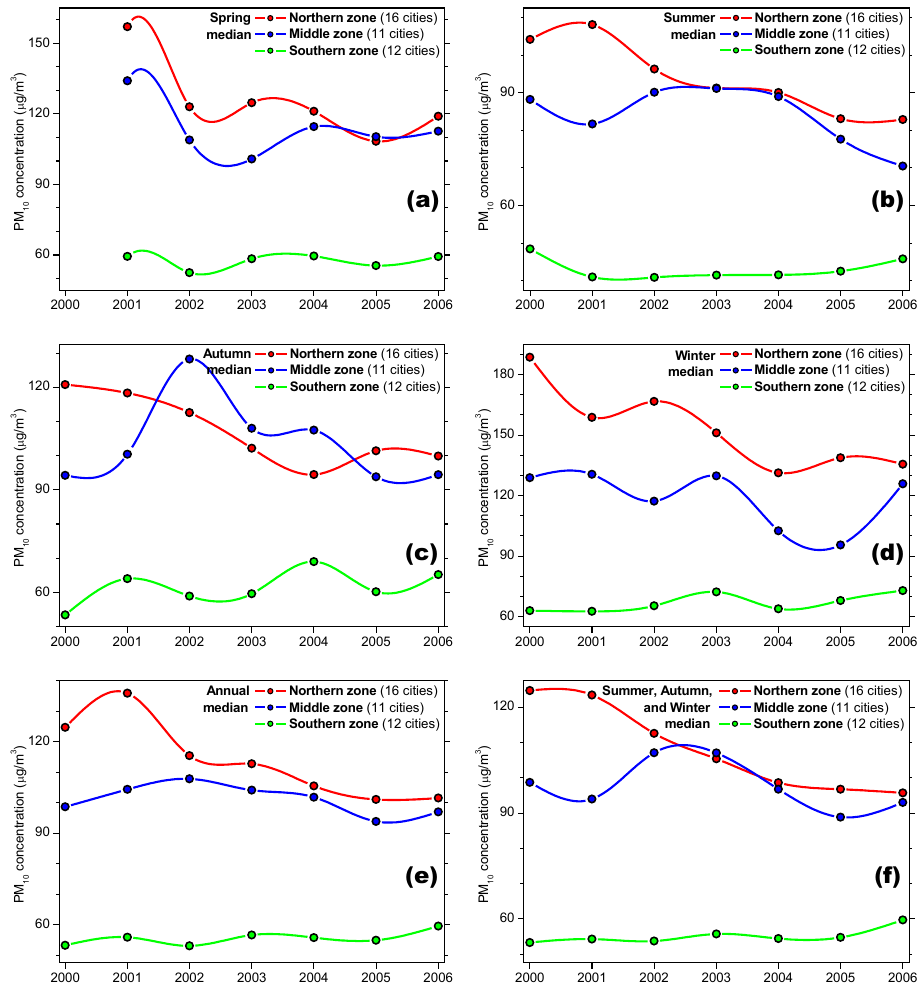
Fig. 7. Interannual variations of the (a) spring, (b) summer, (c) autumn, (d) winter, (e) annual, and (f) summer, autumn and winter combined median PM 10 concentrations for the three latitudinal zones from 2000 to